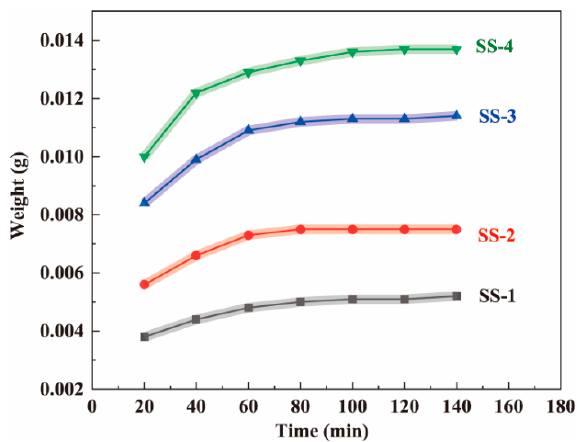
Figure 2. The effect of soaking time in the sodium silicate solutions (SS-1, SS-2, SS-3, and SS-4, respectively) on the weight of the dried BC wet gel samples.